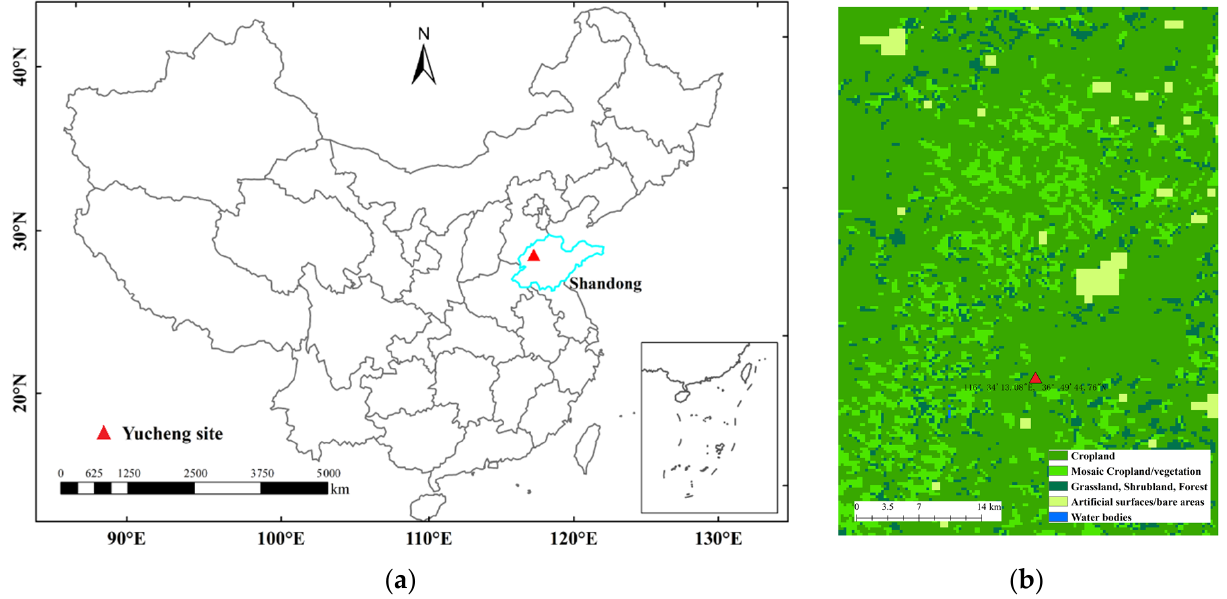
Figure 2. Location map of the Yucheng experimental site ( a ) and land cover classification near the Yucheng site in 2009 from Global Land Cover Map in Google Earth Engine ( b ) (Yuchen site was indicated by the filled red triangle and Shandong province was labeled as light blue).